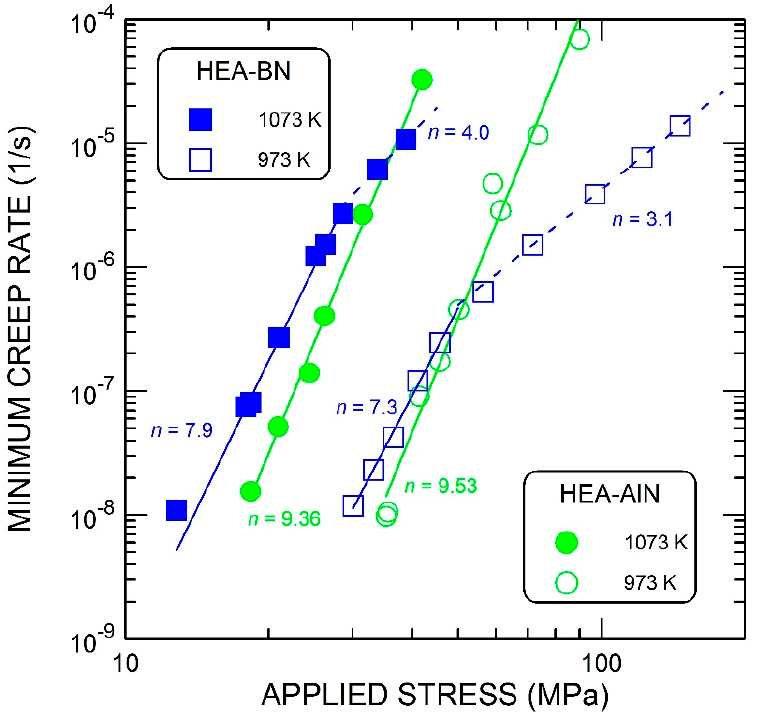
Figure 4. Dependence of the creep rate of the studied alloys on applied stress.